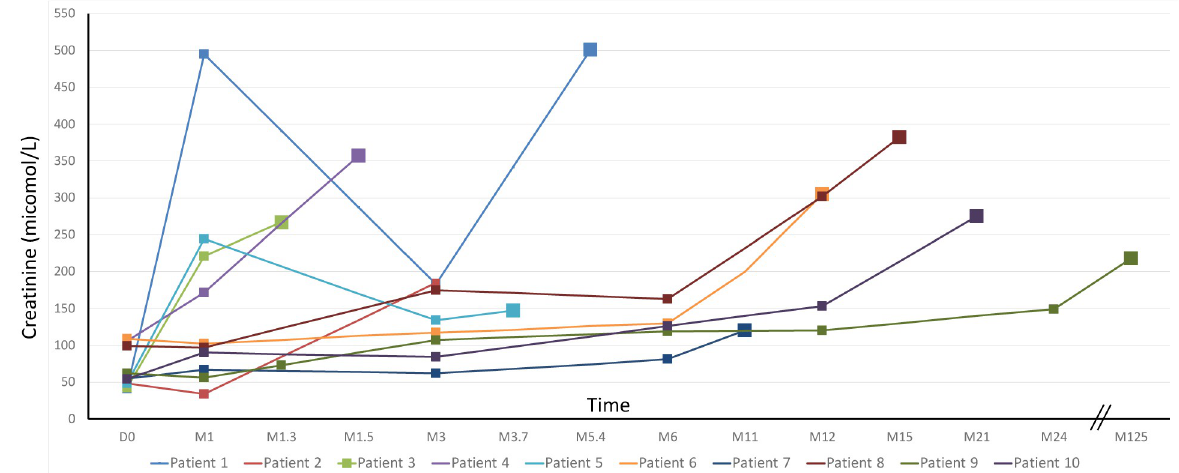
Fig 1. Post-LTx outcome of individual blood creatinine values in the 10 patients before starting belatacept, from day 0 (D0) of transplantation to the day of conversion to belatacept.